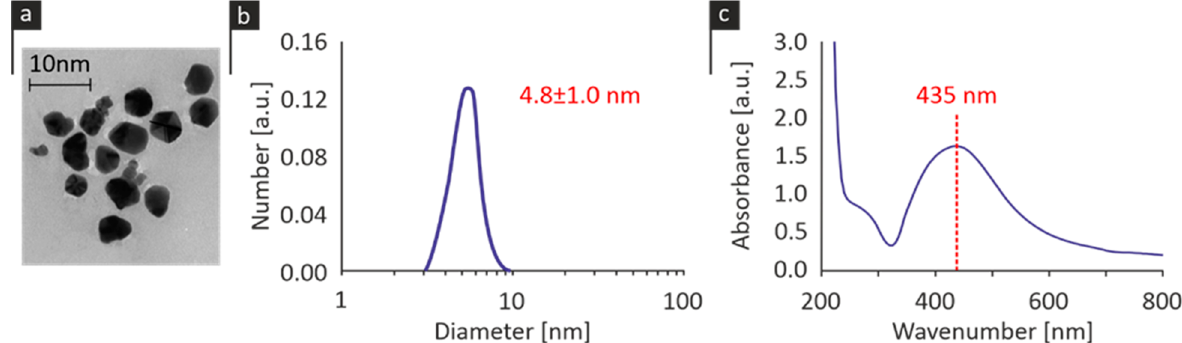
Figure 1. ( a ) Particle size and shape as determined by HR ‐ TEM, ( b ) size distribution of the NPs populations, and ( c ) UV ‐ Vis spectrum of the AgNPs sample.